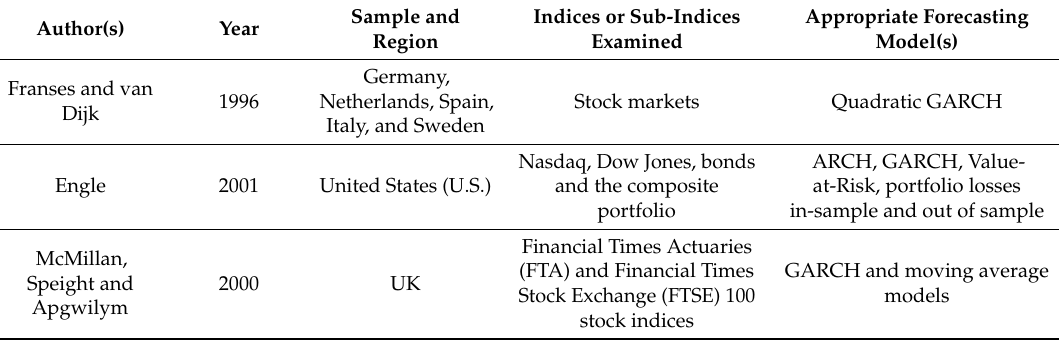
Table A1. Further Relevant Literatures on Modeling and Forecasting Volatility. This exhibit provides a partial list of the relevant literature on modeling and forecasting volatility from the early 1996 to